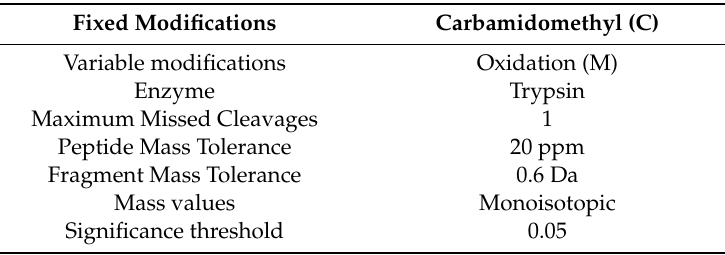
Table 6. Database retrieval